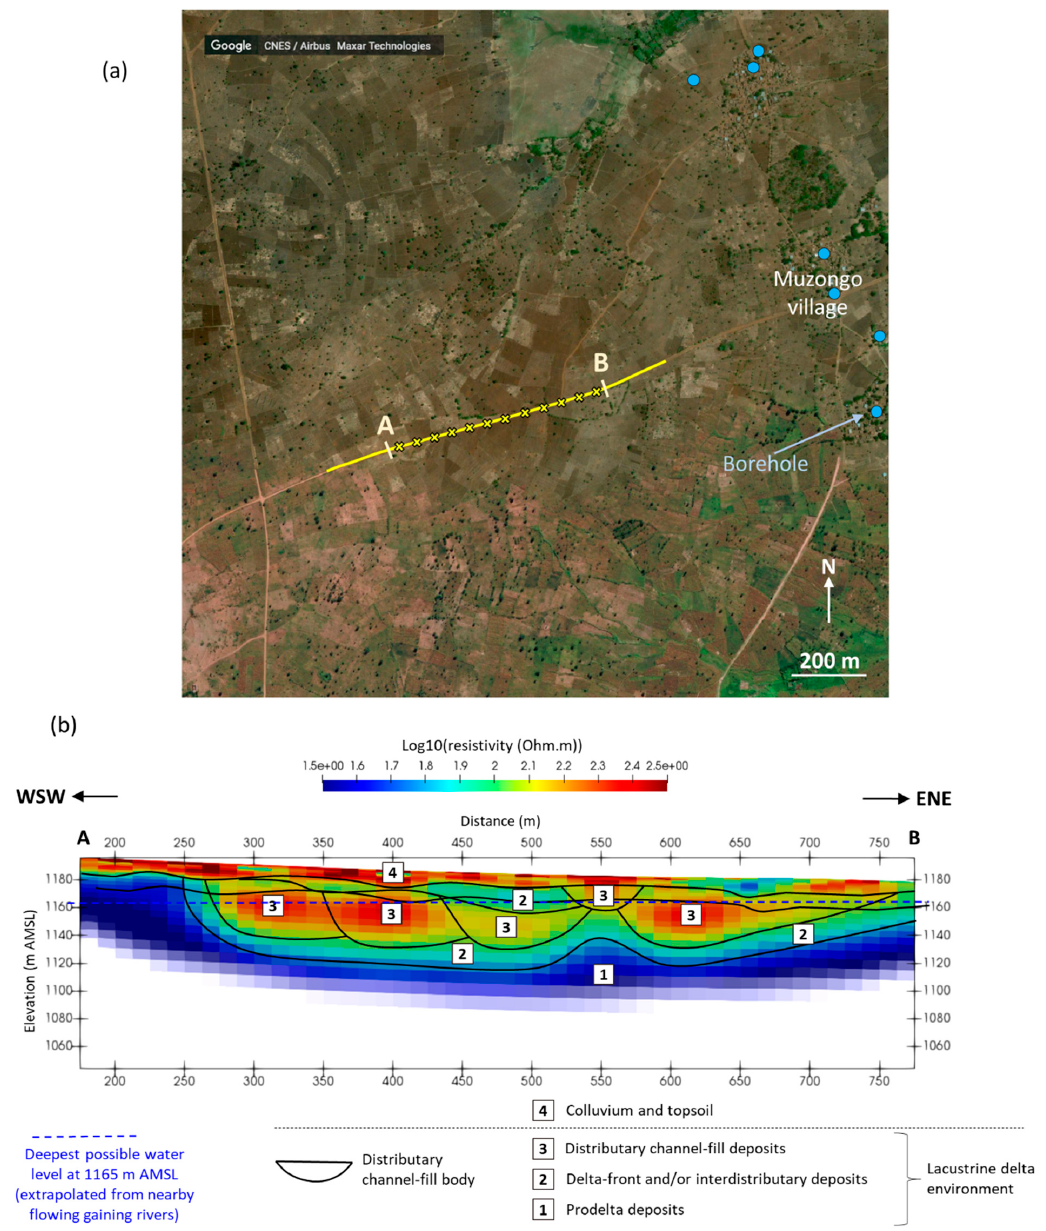
Figure 9. Muzongo survey: ( a ) site survey line location (with individual sounding mid points marked as crosses) shown on a Google Earth satellite image (July 2020 download) of the area; and, ( b ) interpreted subsurface resistivity cross-section obtain for section line AB marked on ( a ) (interpretation includes consideration of outcrop analysis (Figure 10)).